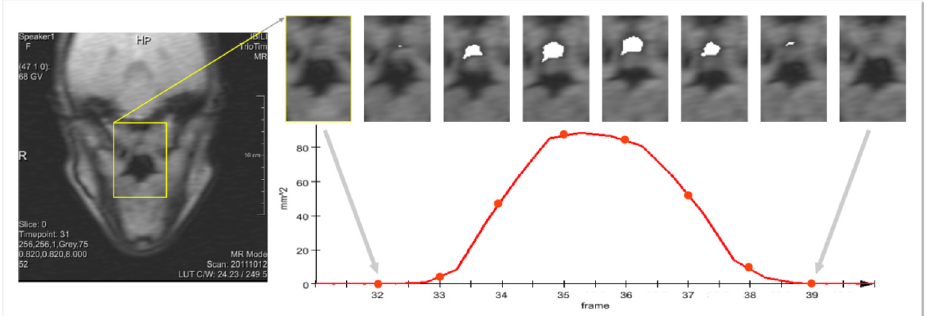
Fig 4. Coronal-oblique RT-MRI images depicting the nasal cavity (in white), over time, and the curve derived for analysis purposes.